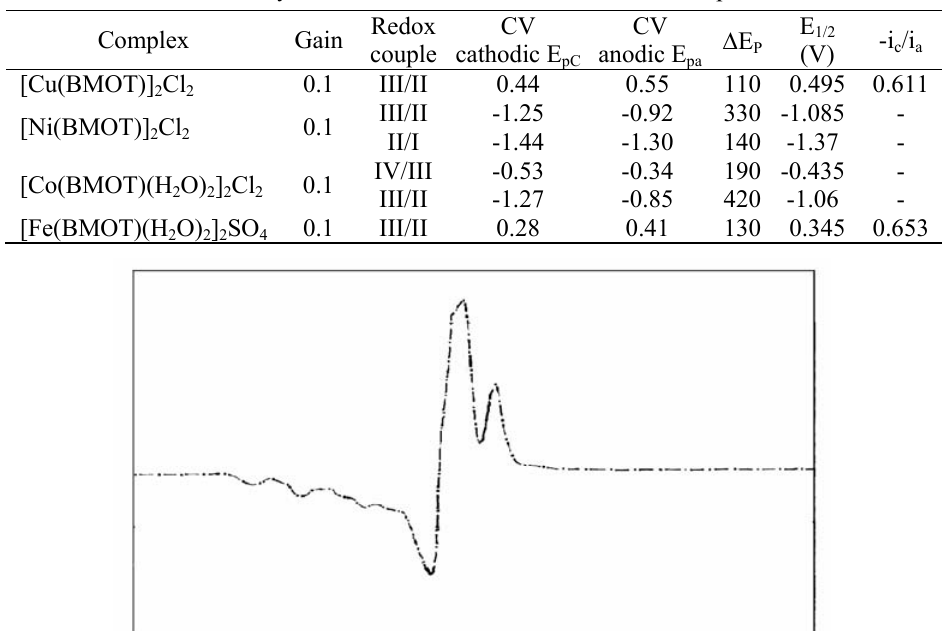
Table 5. Cyclic volta metric data of BMOT metal complexes